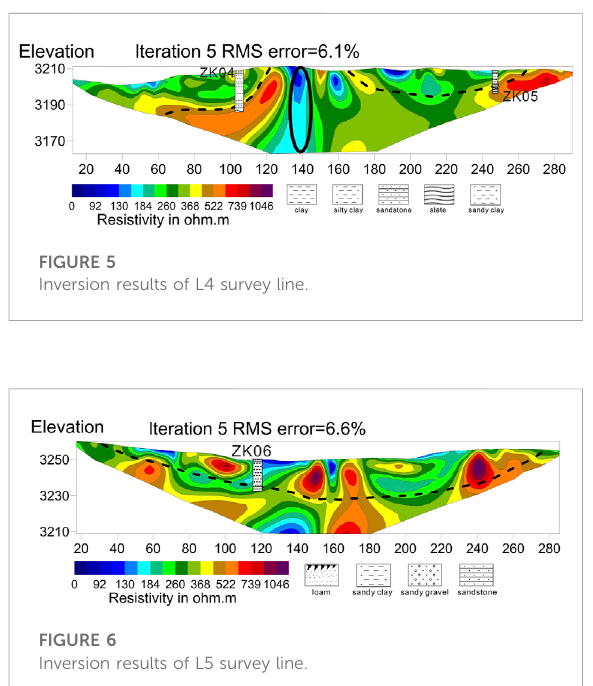
FIGURE 4 Inversion results of L3 survey line.